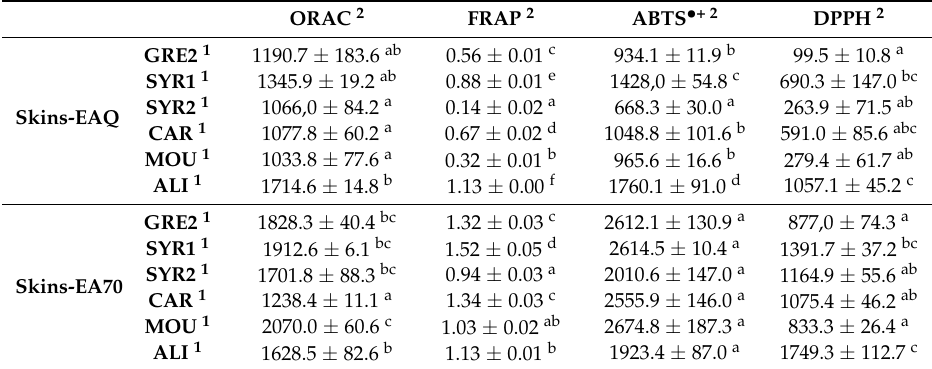
Table 2. Antioxidant activity characterisation in EAQ and EA70 grape pomace skin